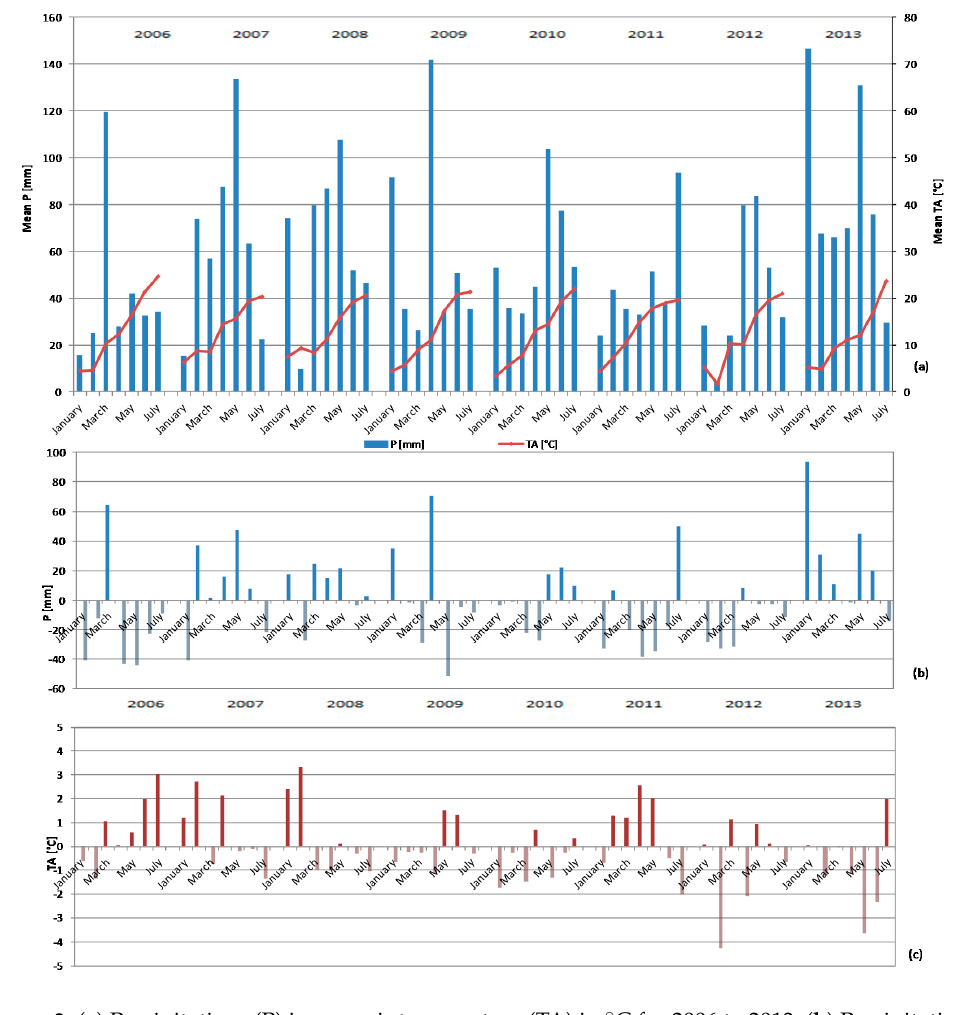
Figure 3. ( a ) Precipitations (P) in mm, air temperature (TA) in °C for 2006 to 2013; ( b ) Precipitations: difference between the monthly average and the monthly average over 8 years; ( c ) Air temperature: difference between the monthly average and the monthly average over 8 years.